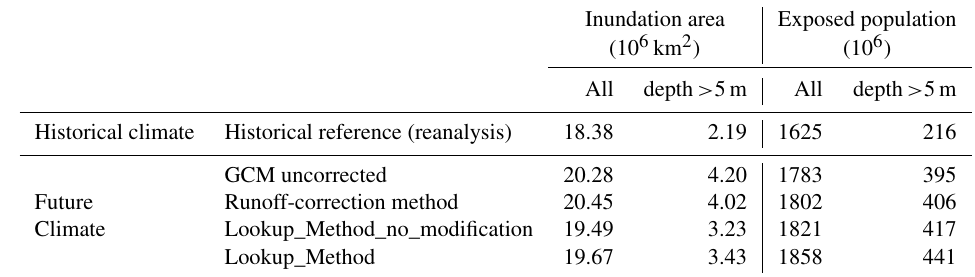
Table 2. Inundation area of the 100-year RP hazard maps and affected population from the 100-year RP hazard maps constructed using various methods; “_no_modification” indicates a map constructed without Backwater_Modification. These results were obtained using IPSL-